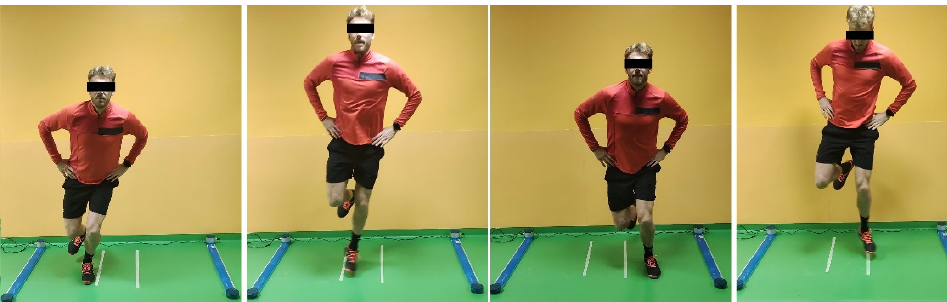
Figure 4. Monopodalic side hop test.